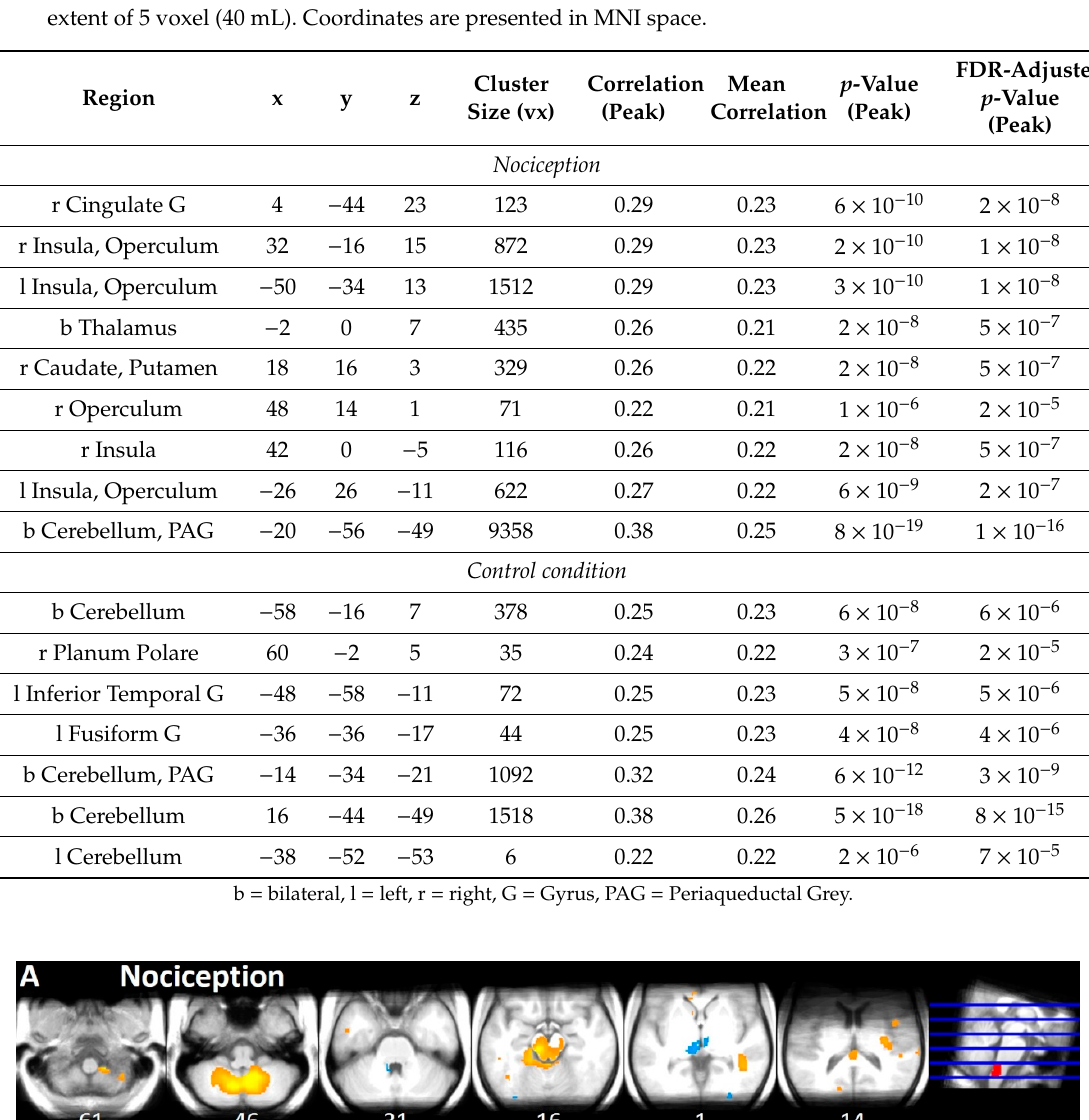
Table 1. Results for the Similarity analysis during trigeminal nociception (gaseous ammonia) and control condition (air pu ff s) at a statistical threshold of FDR-adjusted p < 0.0001 and a minimum cluster extent of 5 voxel (40 mL). Coordinates are presented in MNI space.